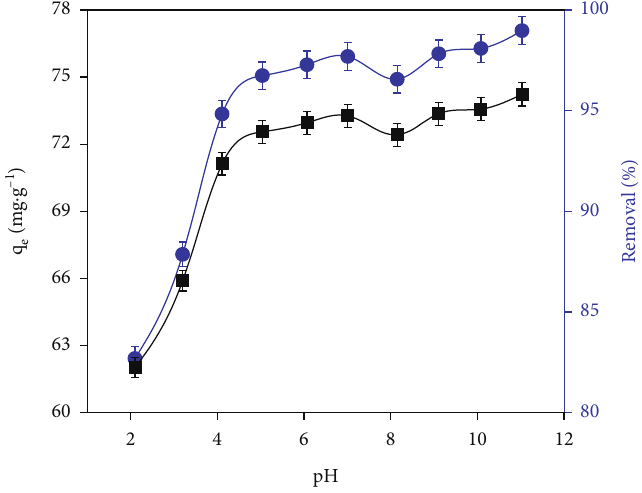
Figure 5: E ff ect of pH on the adsorption of 150mg · L -1 of BF on TKC at 30 °